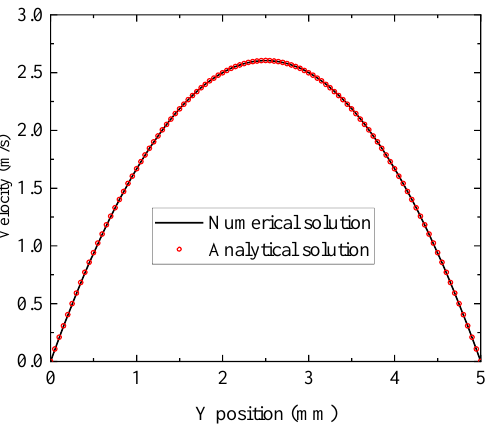
Figure 4. Comparison of the numerical and the analytical solutions of the Poiseuille flow.